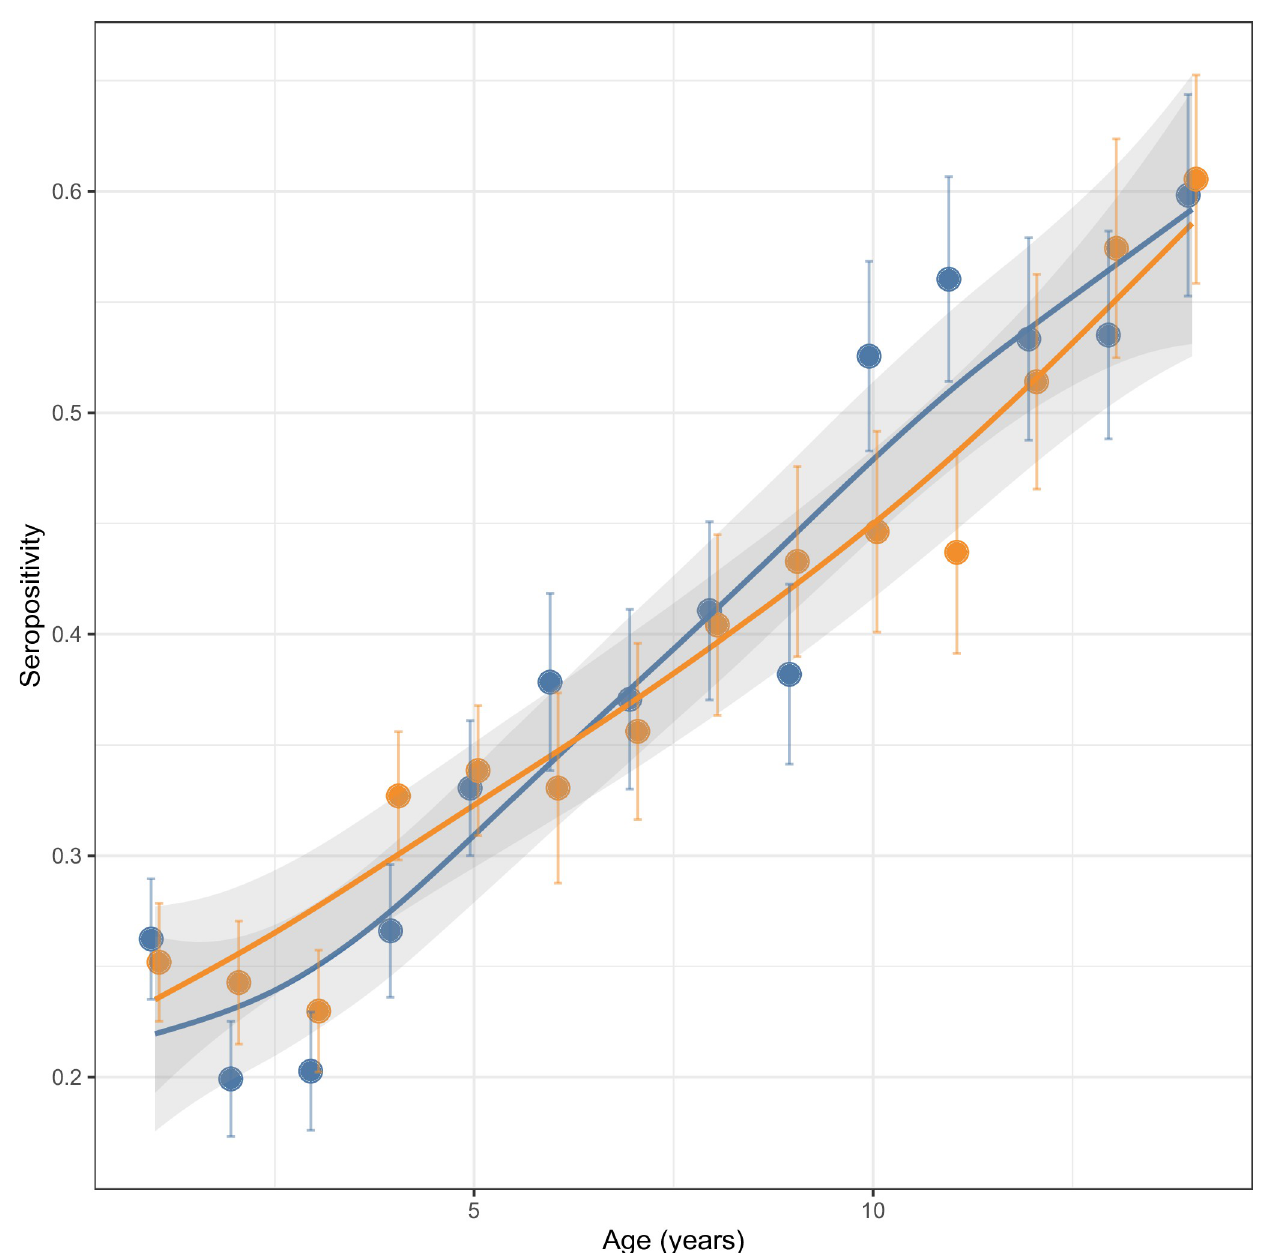
Fig 3. Seropositivity by trial arm and age for any of AMA-1, GLURP-R2, or MSP1-19 antigens in a post-only simple random sample. Data are fitted using a loess smoother function and 95% confidence intervals. RFTAT control (orange) and RFDA intervention (blue) arms are shown accordingly. Plots for individual catchments are shown in S3